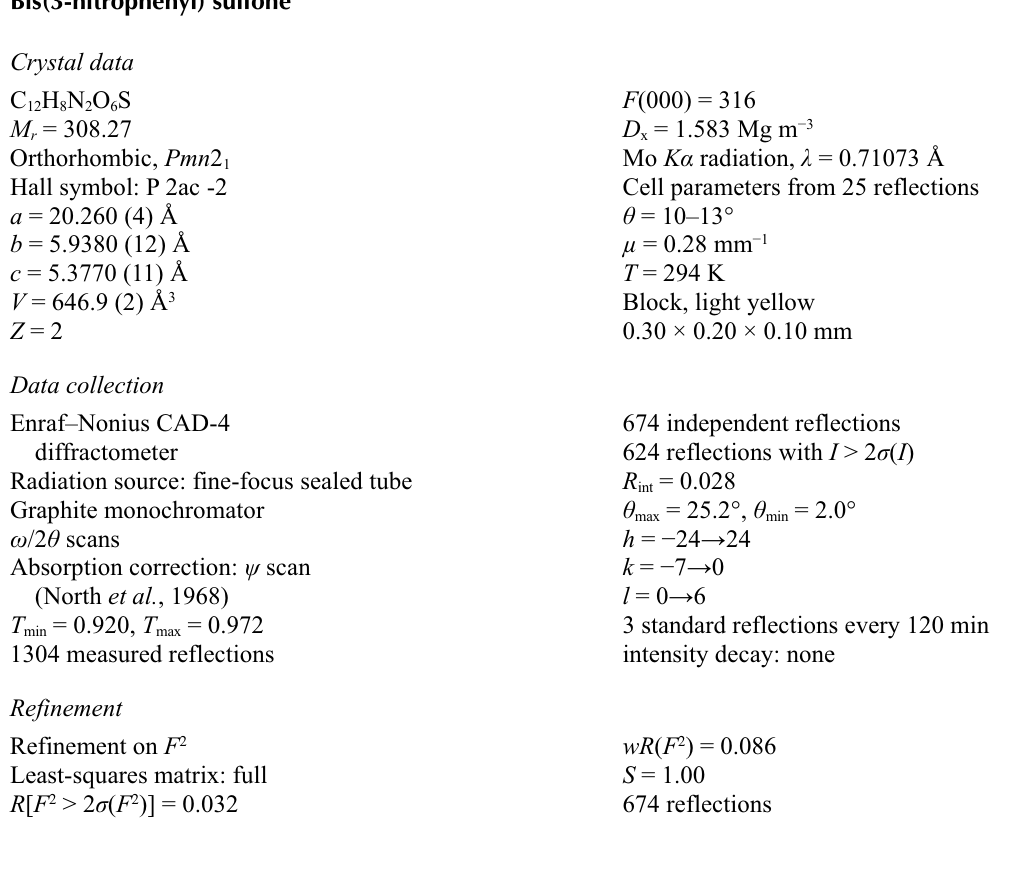
The molecular structure of the title molecule, with the atom-numbering scheme [symmetry code: (′) -x, y, z]. Hydrogen bonds are shown as dashed